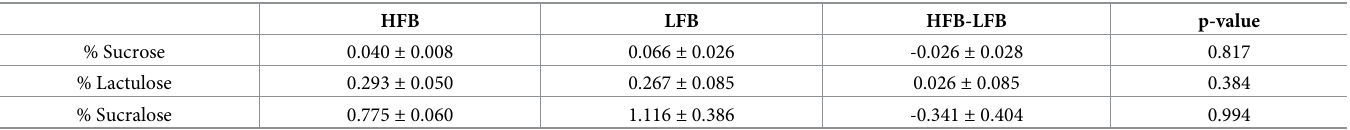
Table 4. Sugar probe excretion